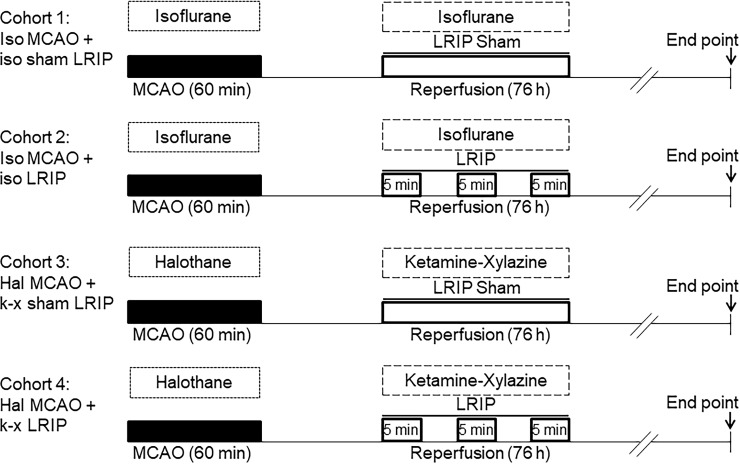
Experimental design.In cohort 1 (Iso MCAO + iso sham LRIP), mice underwent MCAO surgery under isoflurane anesthesia (Fig 1). At 90 min after reperfusion, sham-LRIP was induced under isoflurane anesthesia. In cohort 2 (Iso MCAO + iso LRIP), mice underwent MCAO surgery under isoflurane anesthesia. At 90 min after reperfusion, LRIP was induced under isoflurane anesthesia. In cohort 3 (Hal MCAO + k-x sham LRIP), mice underwent MCAO surgery under halothane anesthesia. At 90 min after reperfusion, sham-LRIP was induced under ketamine-xylazine anesthesia. In cohort 4 (Hal MCAO + k-x LRIP), mice underwent MCAO surgery under halothane anesthesia. At 90 min after reperfusion, LRIP was induced under ketamine-xylazine anesthesia. In cohorts 2 and 4, LRIP was induced at 90 min after reperfusion by three cycles of 5 min ischemia/5 min reperfusion of bilateral hind limb for one session per day for a total of four sessions.